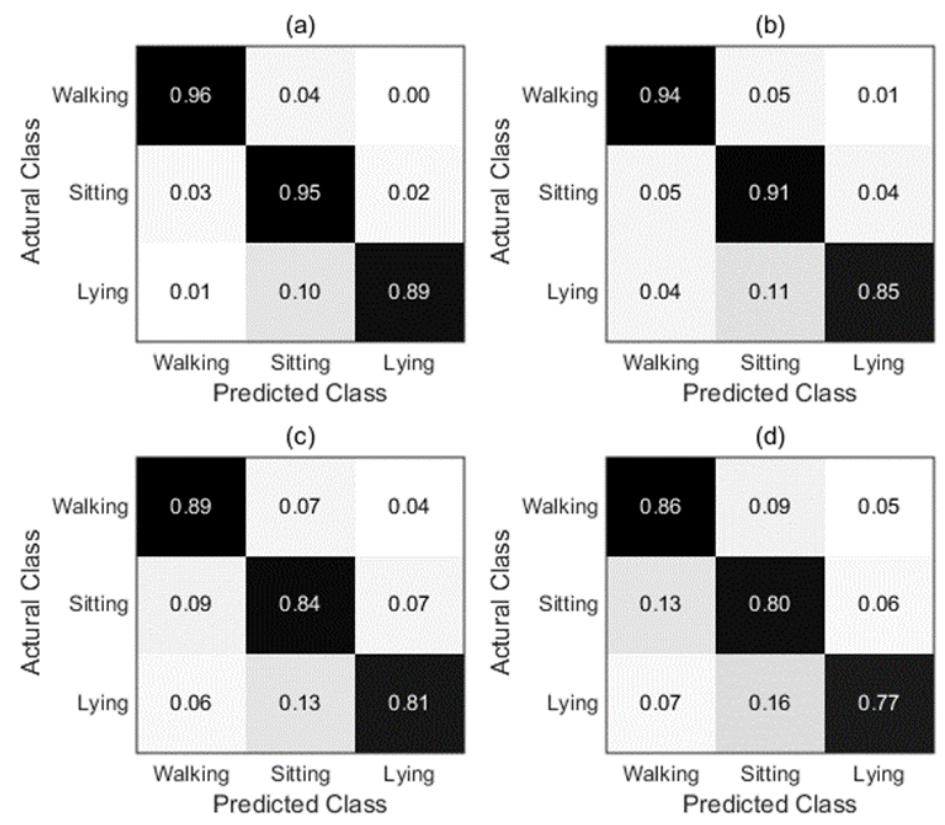
Figure 8. Confusion matrices comparison of different combination strategies for subject 1 in OPPORTUNITY dataset. ( a ) GDM fusion; ( b ) GA; ( c ) WA; ( d ) MV.